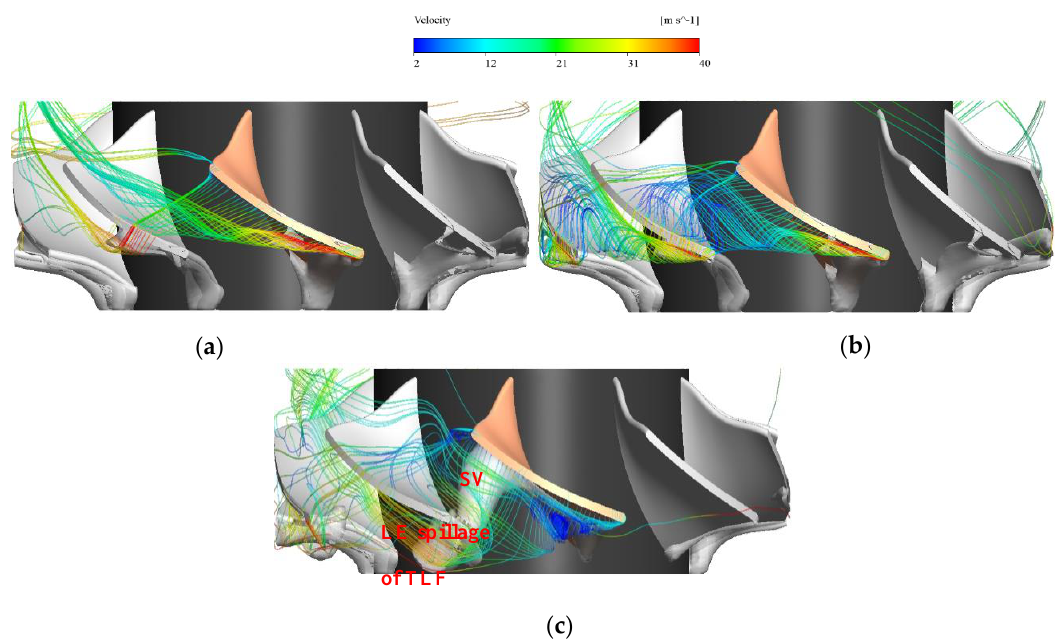
Figure 20. Transient process of tip leakage flow from pre-stall stage to post-stall stage: ( a ) pre-stall stage, ( b ) emerging spike, ( c ) post-stall stage.